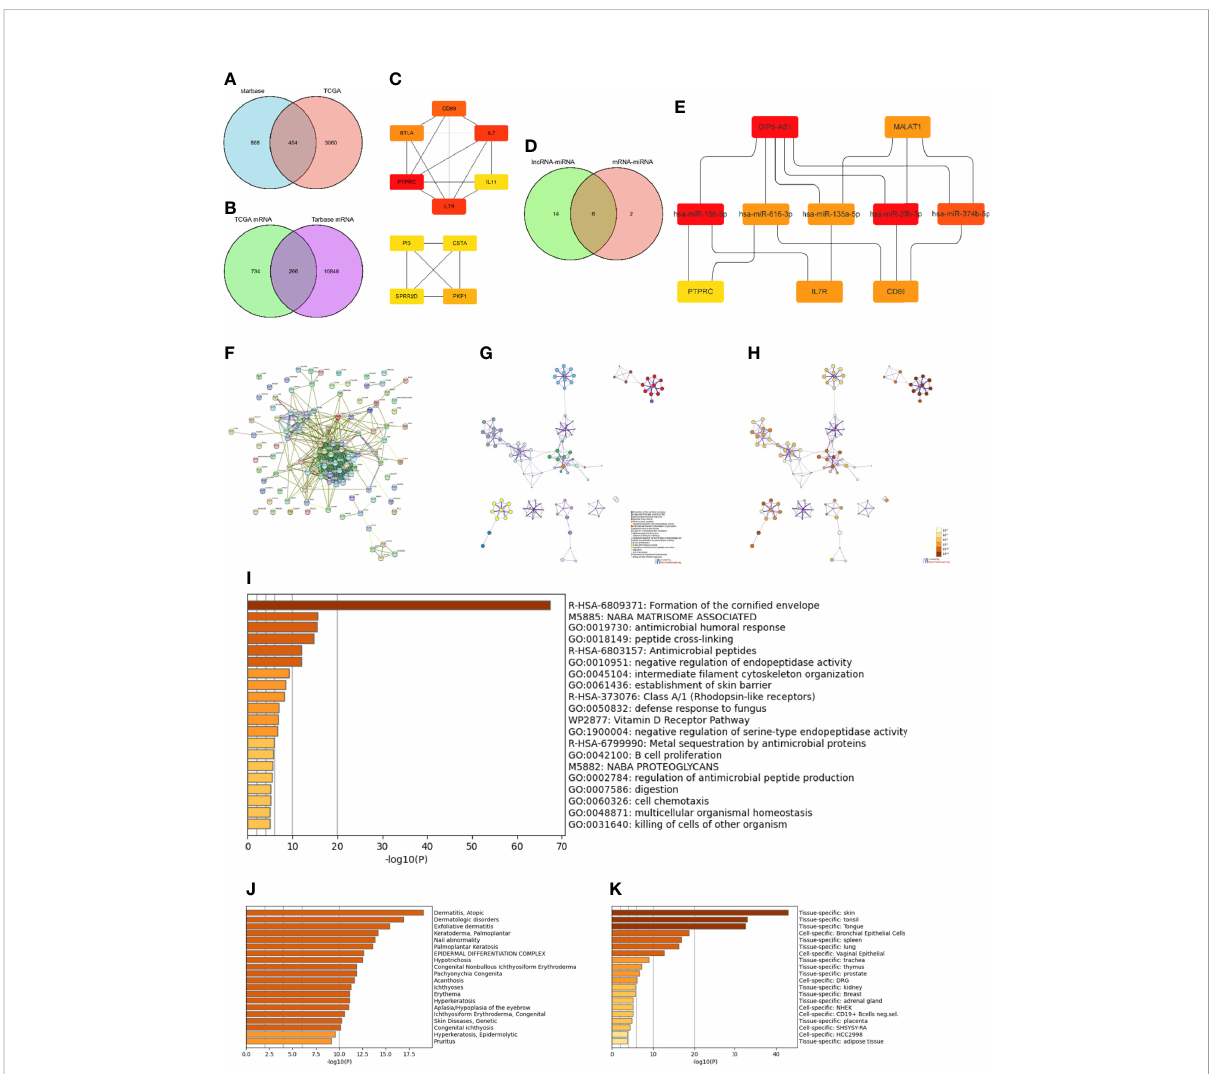
FIGURE 4 Construction and functional enrichment analysis of the lncRNA-miRNA-mRNA triple regulatory network. (A) Venndiagram of the 1272 lncRNAs predicted by the starBase database based on corresponding DEmiRNAs and 3464 DElncRNAs selected through the TCGA database analysis. (B) Venndiagram of 1000 DEmRNAs selected from TCGA and 11,114 mRNAs predicted from the DEmiRNAs in the TarBase database. (C) Interaction network analysis of core DEmRNAs obtained by Cytoscape. (D) Eight miRNAs predicted by the three most signi fi cant mRNAs intersected with the 20 miRNAs predicted from the top ten DElncRNAs. (E) Core ceRNA network predicted by the CytoHubba plug-in of Cytoscape. (F) Interaction regulatory network of 100 important DEGs related to the core ceRNA network obtained through STRING. (G) Enrichment analysis of the DEGs in (F) obtained by Metascape. (H) Signi fi cance of the enriched KEGG pathways. (I) Enriched terms in the DEmRNAs as obtained in Metascape, colored by p-values. (J) Enrichment analysis of DEmRNAs in DisGeNET, colored by p-values. (K) Enrichment analysis of DEmRNAs in PaGenBase, colored by